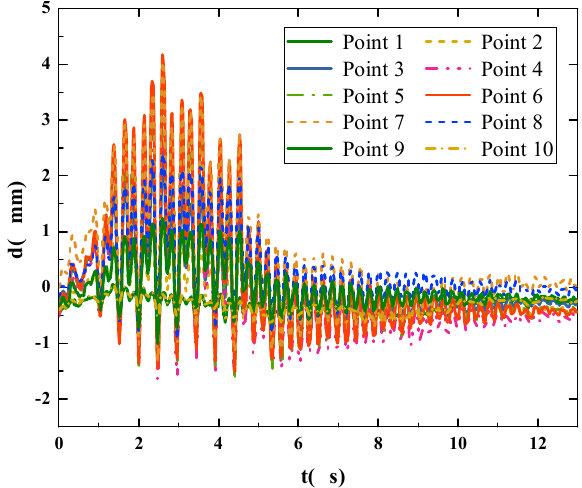
( b ) Figure 10. Mid-span displacement comparison chart. ( a ) Displacement time-history comparison chart; ( b ) displacement frequency-domain comparison chart.